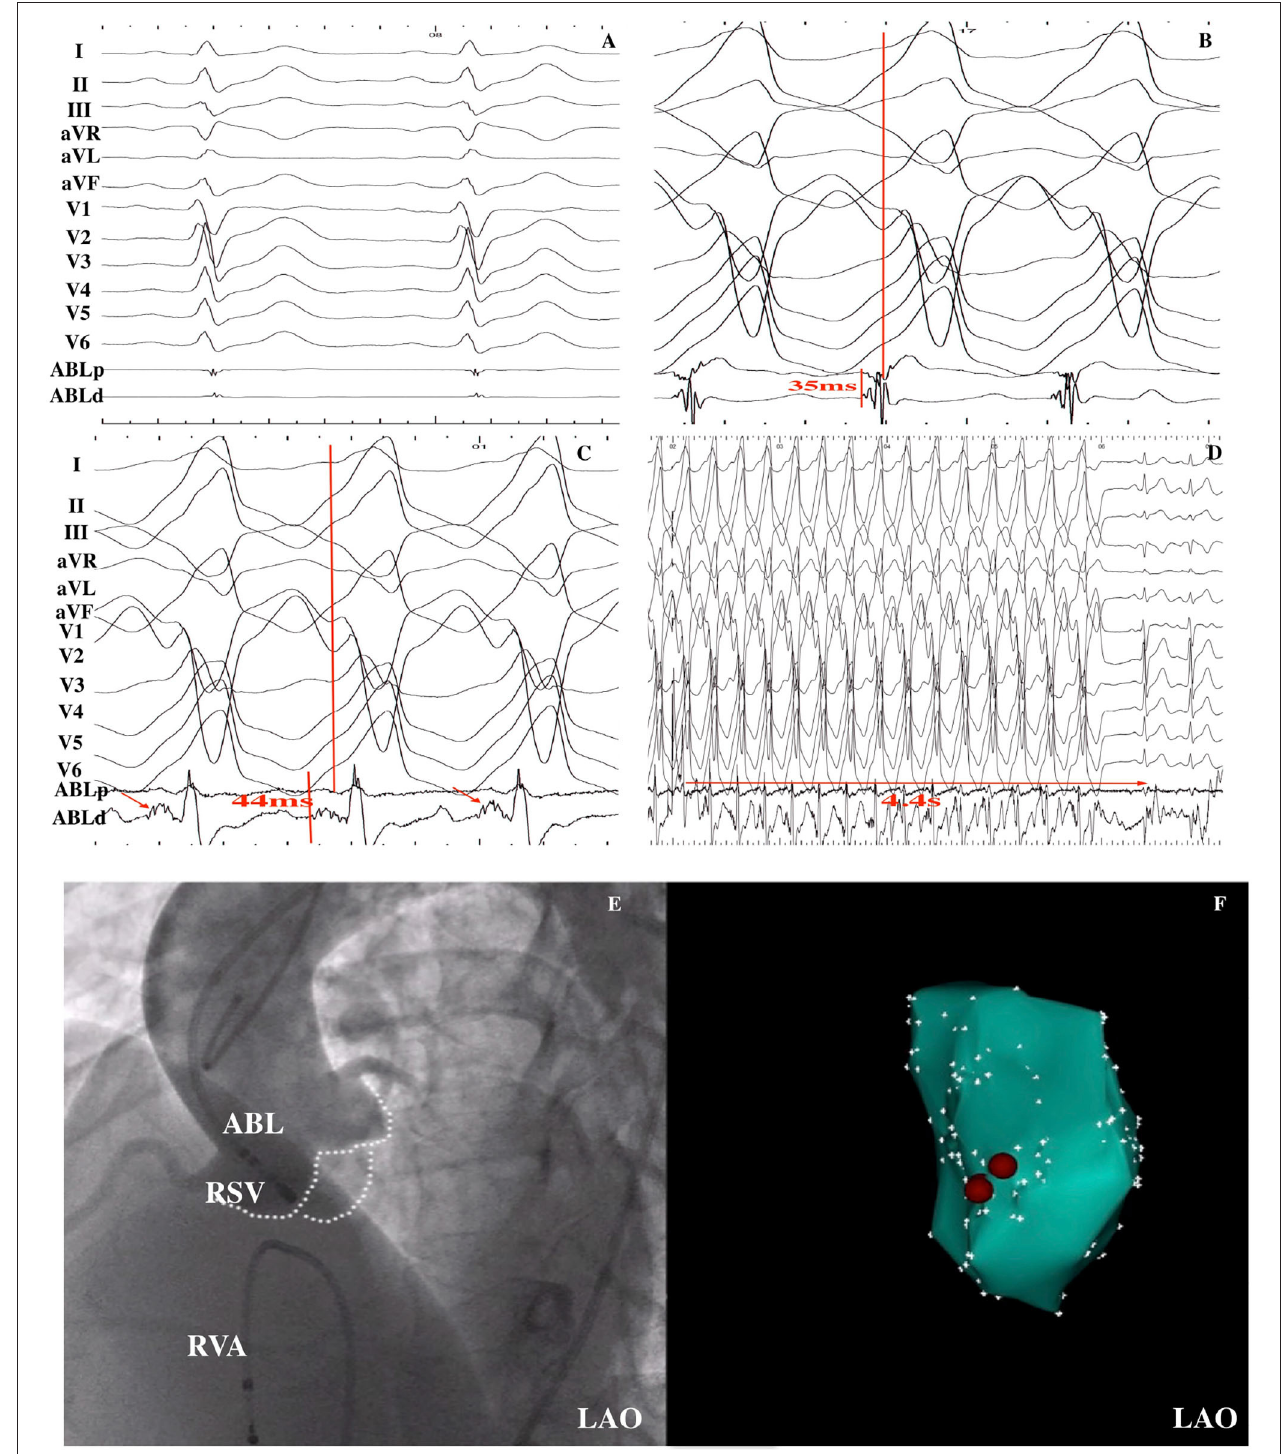
FIGURE 3 | VT was successfully ablated within the RSV in a 15-year-old male patient. (A) Baseline 12-lead ECG was shown; (B) An early ventricular activation preceded by QRS by 35ms during the VT was recorded at the RVOT, but ablation was ineffective. (C) Fragmented potential (red arrow) was found at the RSV, and the interval from the potential to QRS onset was 44ms. (D) After RF energy delivery, VT was terminated after 4.4s. (E) LAO fluoroscopic view of the mapping catheter at the successful ablation site as demonstrated by aortic artery angiography. (F) Electroanatomical CARTO map of the VT in the LAO view. Red points indicate ablation points. RSV, right sinus of Valsalva; RF, radiofrequency ablation; VT, ventricular tachycardia; LAO, left anterior oblique; ABL, ablation catheter; RVA, right ventricular apex.